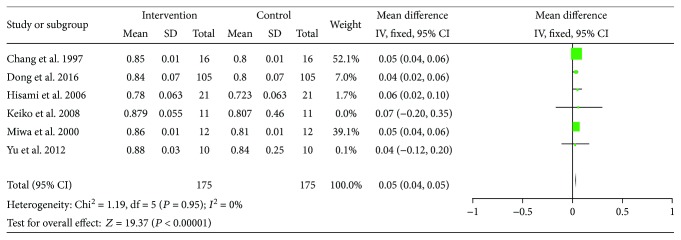
Forest plot for RQ.